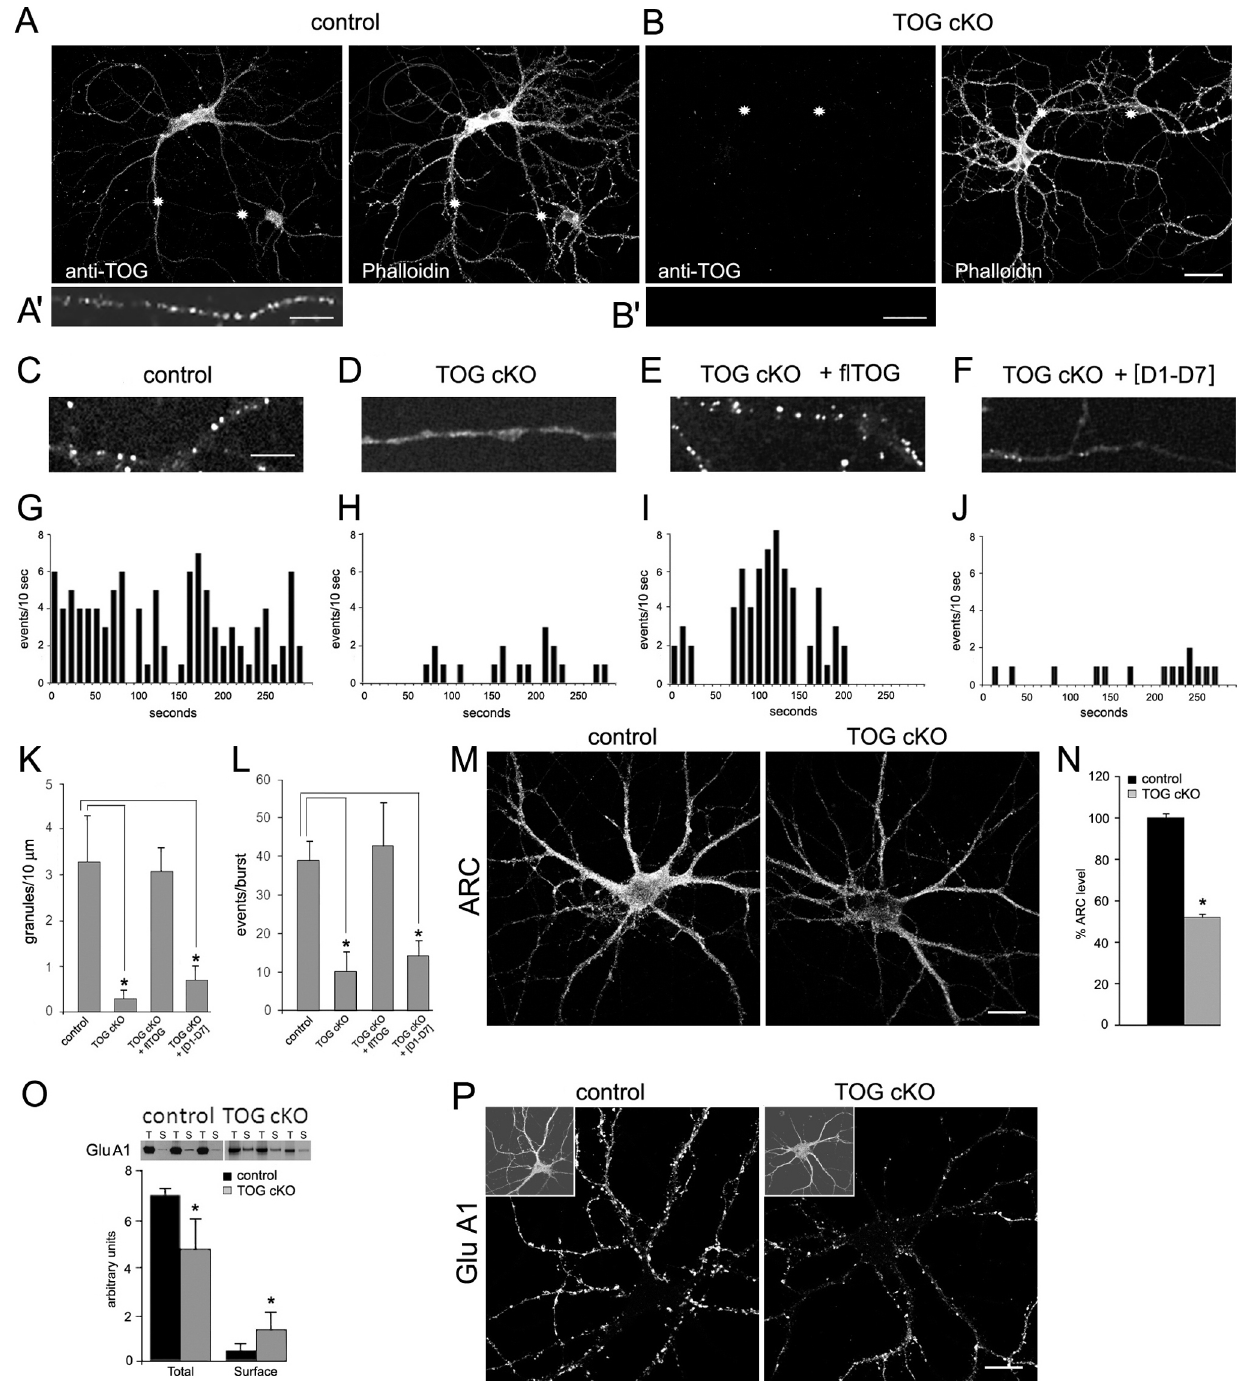
Figure 3. TOG expression, granule assembly, granule translation and ARC expression in control and TOG cKO hippocampal neurons in culture. A. Fluorescence microscopic images of a cultured control neuron co-stained with anti-TOG and Alexa 488 conjugated secondary antibody and Texas-red conjugated phalloidin to label f-actin. A’. High magnification of the dendritic segment identified by 2 asterisks in A and stained with anti-TOG. Scale bar =10 m m. B. Fluorescence microscopic images of 2 cultured TOG cKO neurons co-stained with anti-TOG and Alexa 488 conjugated secondary antibody and Texas-red conjugated phalloidin. B’. High magnification of the dendritic segment identified by 2 asterisks in B and stained with anti-TOG. Scale bar =10 m m. C – F. Subcellular distribution of microinjected Venus-ARC RNA (labeled with Cy5-UTP) in control (C) and TOG cKO (D) hippocampal neurons and in TOG cKO neurons co-injected with full-length recombinant TOG protein (E) or with an equal molar mixture of individual TOG domains [D1–D7] (F). Injected cells were visualized by wide field fluorescence microscopy. Scale bar for C – F=10 m m. G – J. Number of translation events per 10 sec is plotted versus time. Representative translation profiles under conditions described in C – F. K. Numbers of Venus-ARC RNA containing granules were counted in 10 m m dendritic segments of neurons treated as in C – F. Values represent average and standard deviations for numbers of granules per 10 m m dendritic segments (t-test, *p , 0.05). L. Numbers of translation events per burst were counted for individual granules in control, TOG cKO, TOG cKO plus full length TOG protein and TOG cKO plus TOG domains in cells injected with